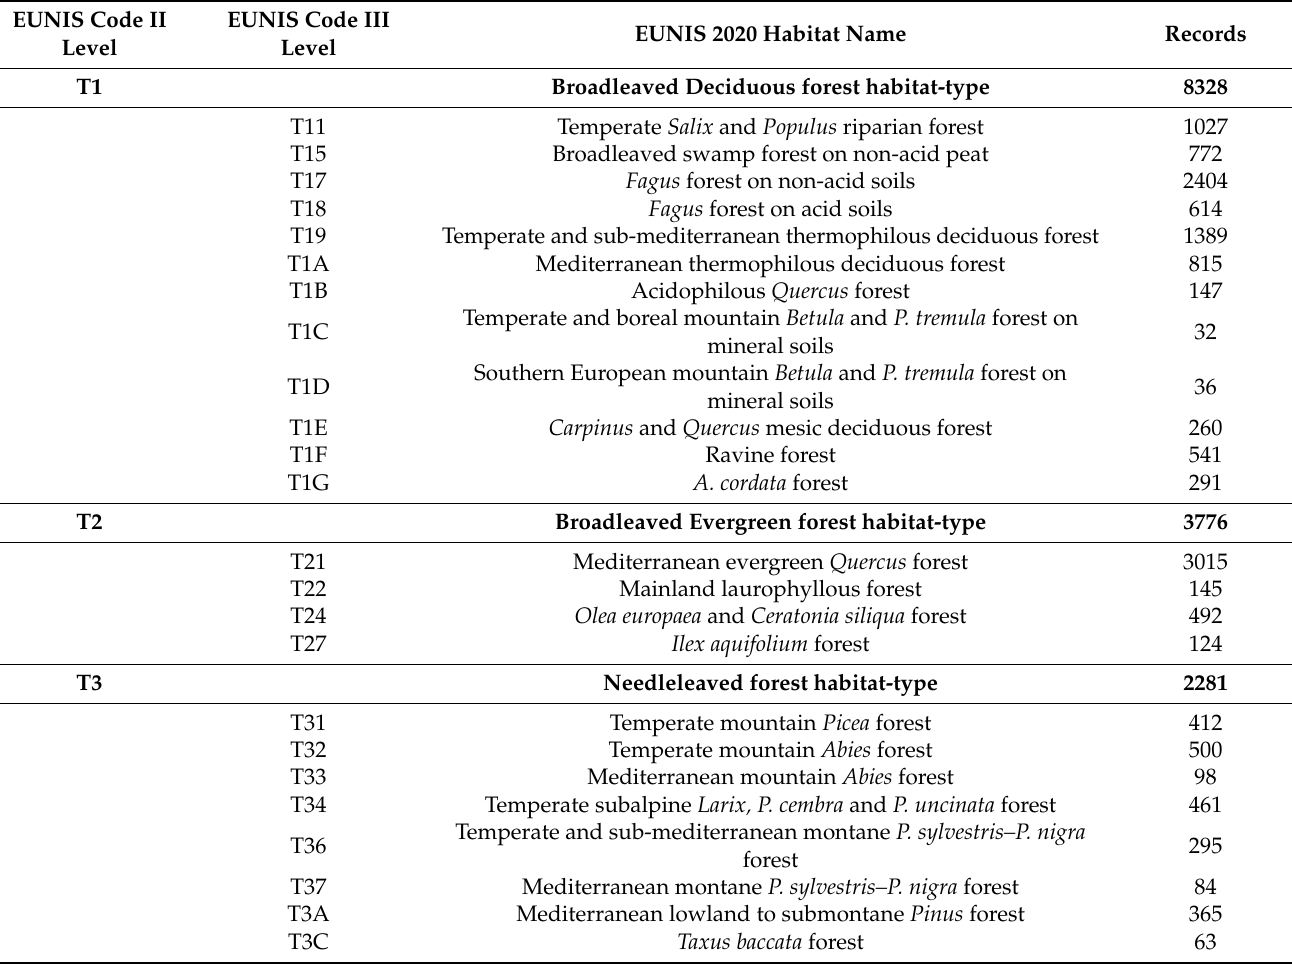
Table 3. Selected habitat plots by expert system classification according to EUNIS code (II and III level). EUNIS Code